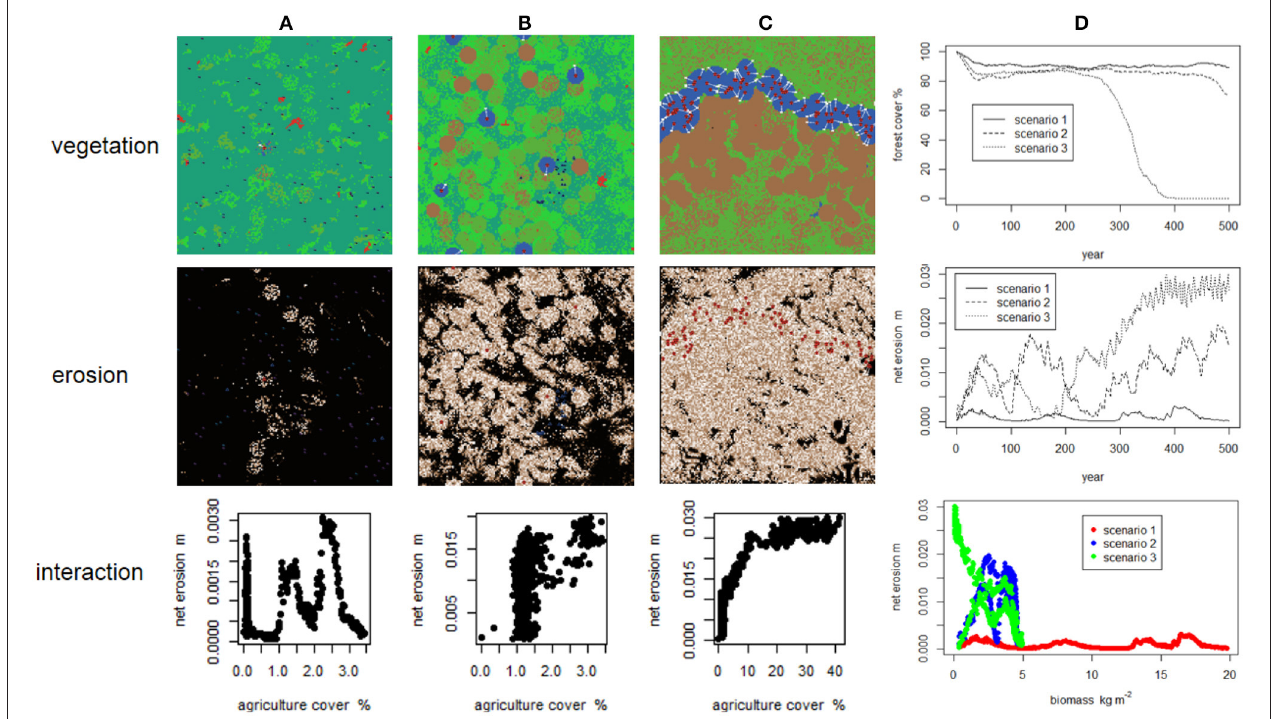
FIGURE 5 | Output from the CybErosion model showing how vegetation and erosion emerge under three scenarios (A–C) about the nature of human-environment interactions, increasing in intensity and rapidity from left to right. Each grid cell is 100 × 100m in size. Colours in the vegetation maps are as follows: light, medium, and dark green are grass, shrub and forest, respectively; blue areas are in active cultivation, and brown areas were formerly cultivated and are now bare. In the erosion maps (middle row), rates are scaled from high (white) through medium (brown) to low (black). Column (D) shows the temporal dynamics of the forest cover and erosion in the landscape (top and middle) and the relationship between landscape-level biomass and average net erosion (bottom). Figure from Wainwright (2015). Reproduced with the kind permission of John Wiley &